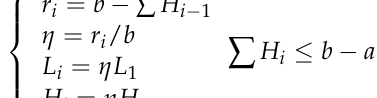
Figure 9. The distribution of the pentamode material cellular in the cloak.